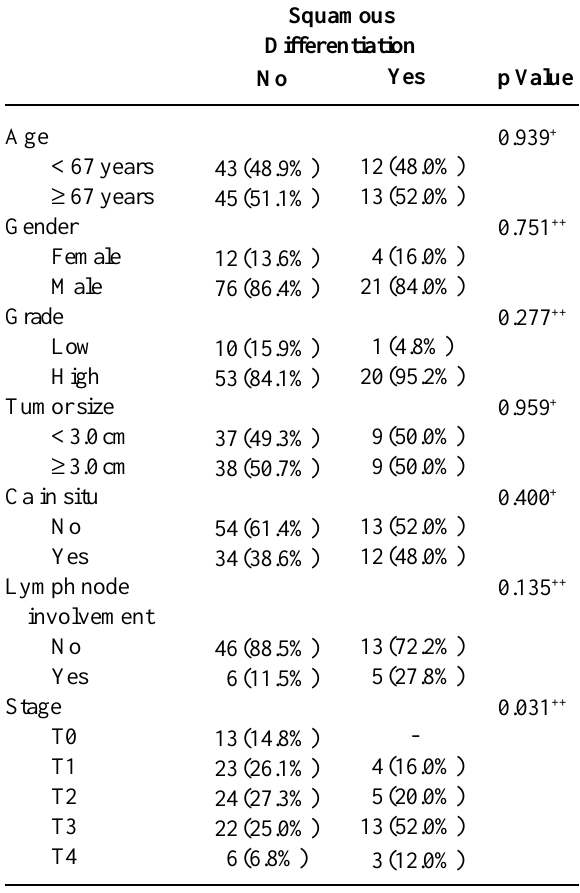
Table 2 – Distribution of variables according to the presence of squamous